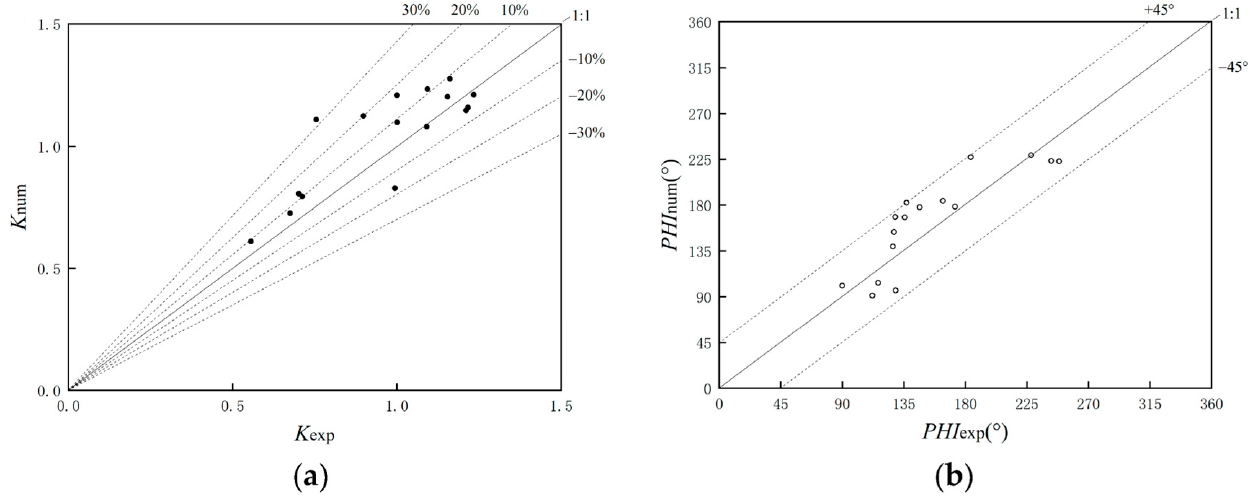
Figure 15. Comparison between numerical simulation results and field measurements. ( a ) Comparison of wind speed ratio obtained in the numerical simulation and field measurement ( b ) Field measured wind direction corresponding to numerical